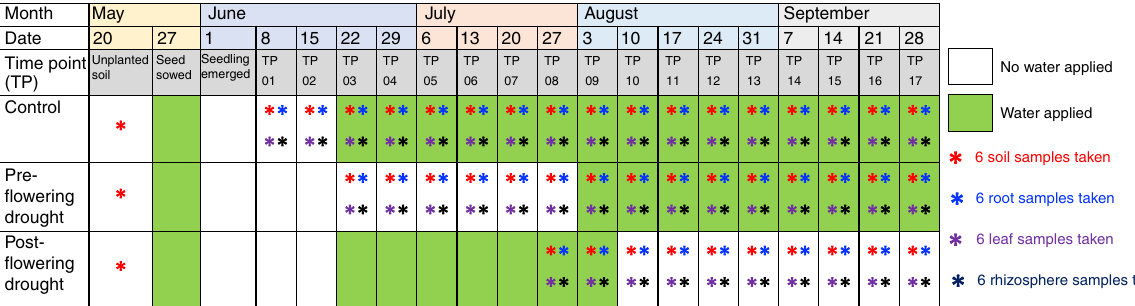
Fig. 1 Experimental design. a Field layout of the 18 plots (16 × 8 m 2 each) in a random block design of three treatments (control, pre- fl owering drought and post- fl owering drought) and two sorghum cultivars (RTx430 and BTx642) with three replicates in a 76 × 59 m 2 fi eld. The discovery that the effect of host genotype is negligible allowed us to use six replicates in most of our analyses. Each plot consisted of ten, 16 m long rows, each containing approximately 200 plants spaced 8 cm apart. b Irrigation scheme and sampling strategy. Irrigation for all treatments was identical until week 3 when pre- fl owering drought was initiated. Irrigation for control and post- fl owering drought was identical until week 10 when post- fl owering drought was initiated. Soil samples were collected 20 cm from the plant stem to a depth of 15 cm with a soil corer, while leaf, rhizosphere and root samples were collected from plants extracted by shovel to a depth of approximately 20 compartments of: soil, rhizosphere, root and leaf (dataset 1: R 2 =